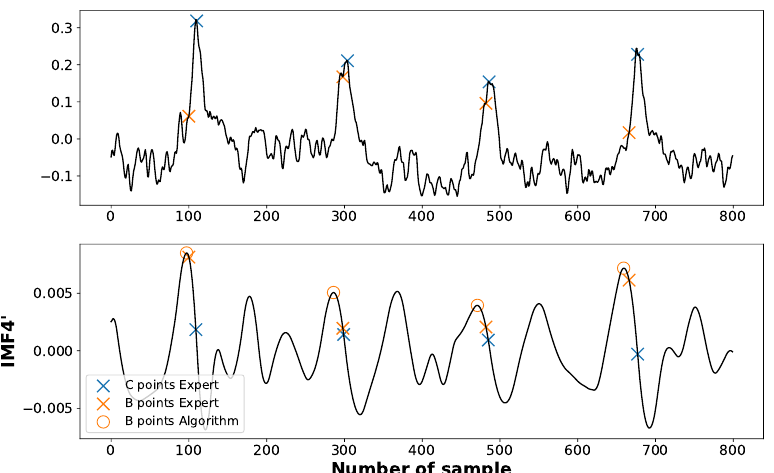
Figure A3. An example of X point misidentification due to the hardly noticeable local minimum in the original signal.